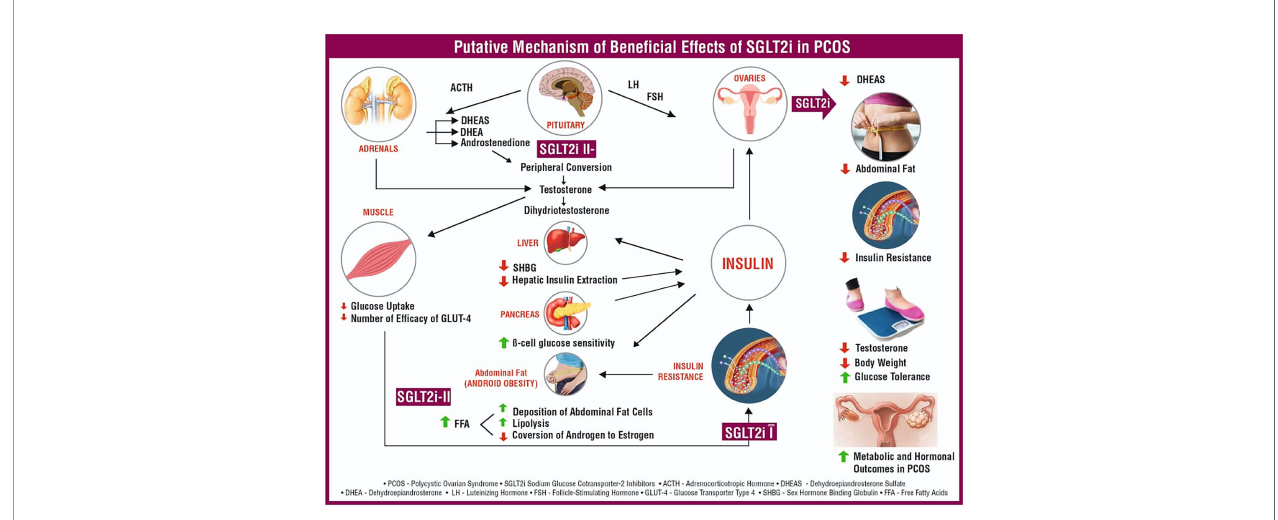
FIGURE 4 | Putative mechanism of the bene fi cial effects of SGLT-2is in